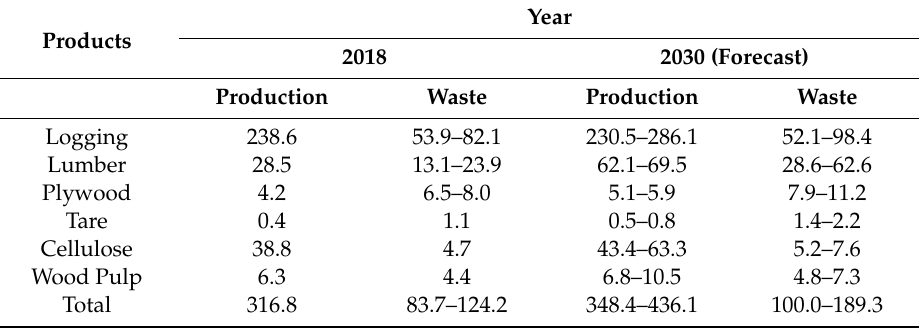
Table 2. Waste generation (fuel resource) in the Russian timber industry complex in 2018 and 2030, mln m 3